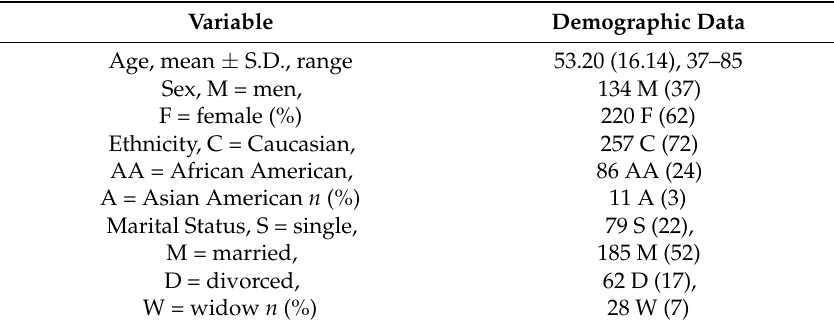
Table 1. Demographic and Neurological Characteristics of the